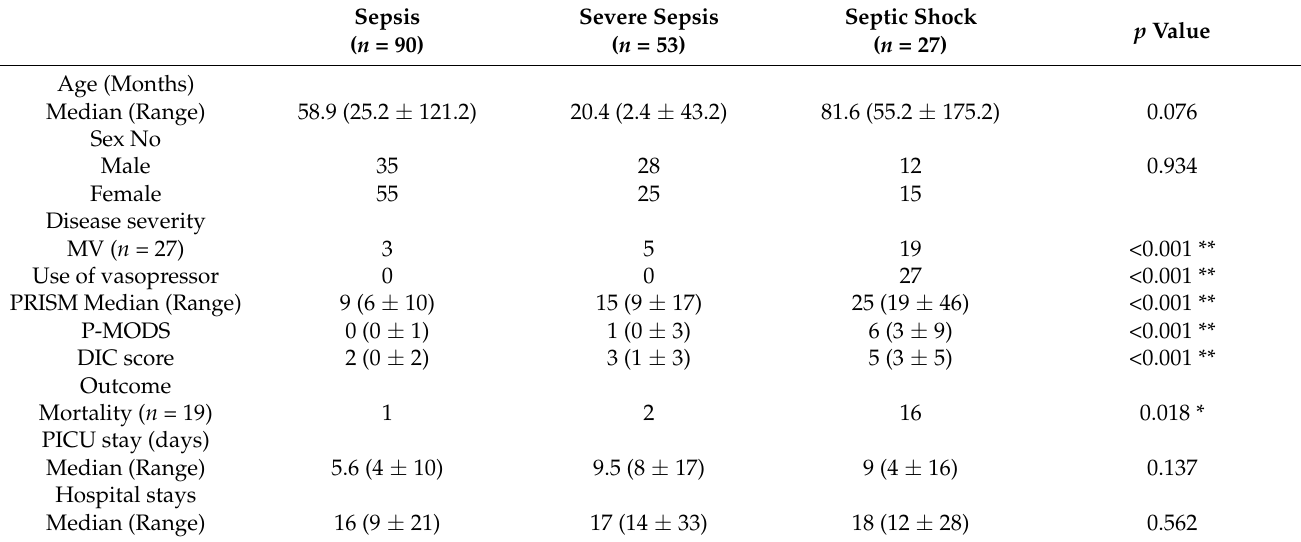
Table 2. Demographic, disease severity and outcome data in studied groups.